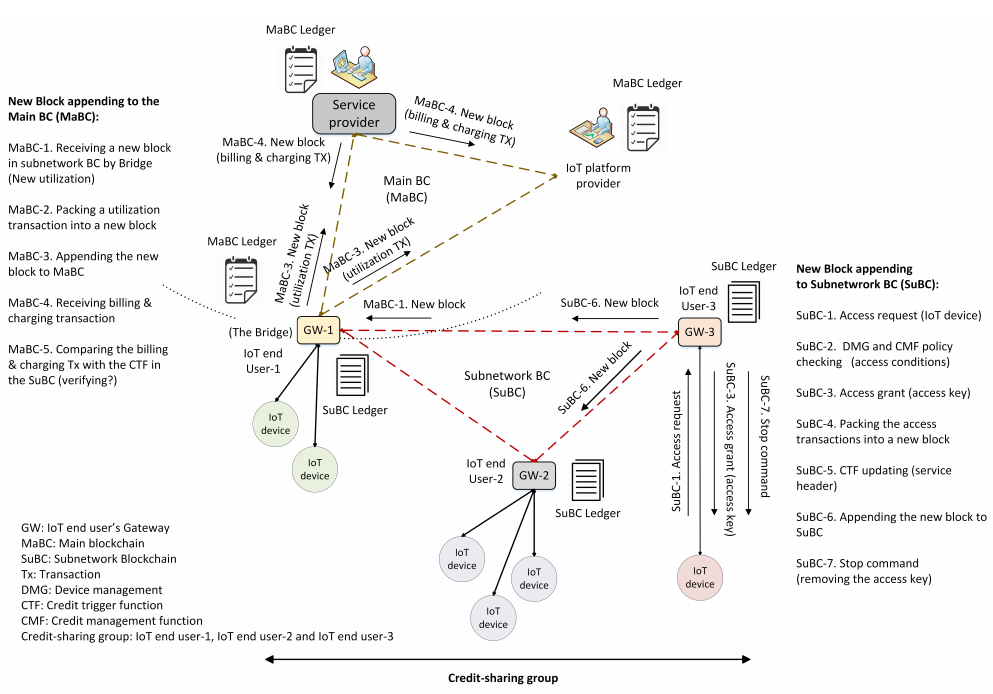
Figure 5. Transactions handling. MaBC-x, transaction progress in MaBC; SuBC-x, transaction progress in